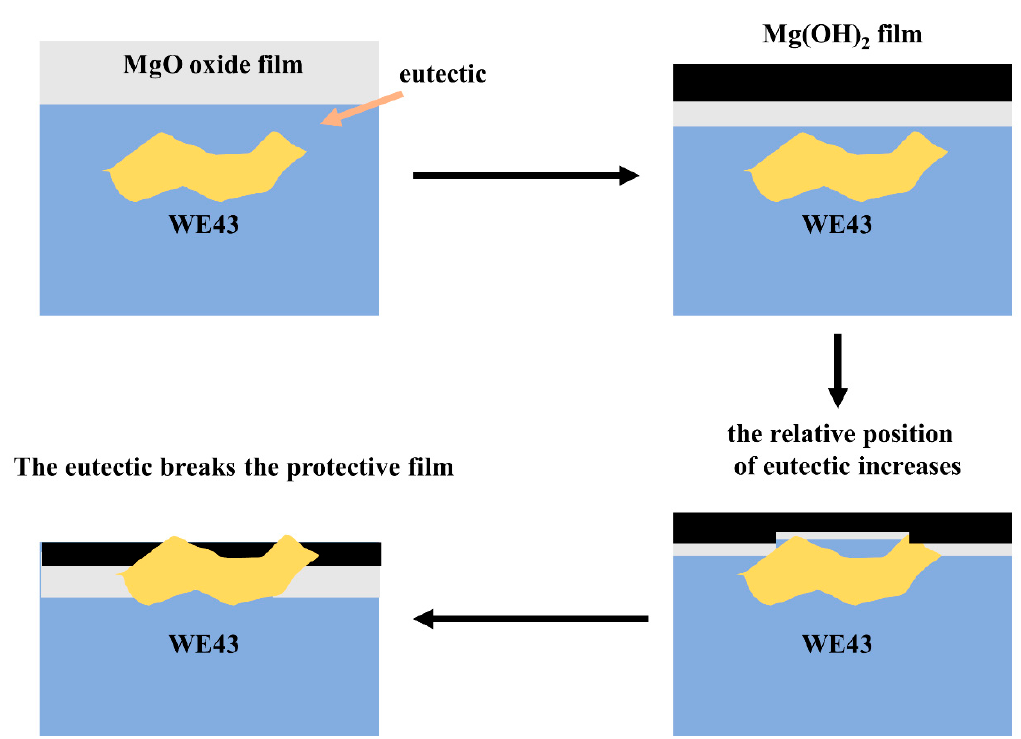
Figure 13. Schematic illustration for the effect of eutectic on corrosion behavior.